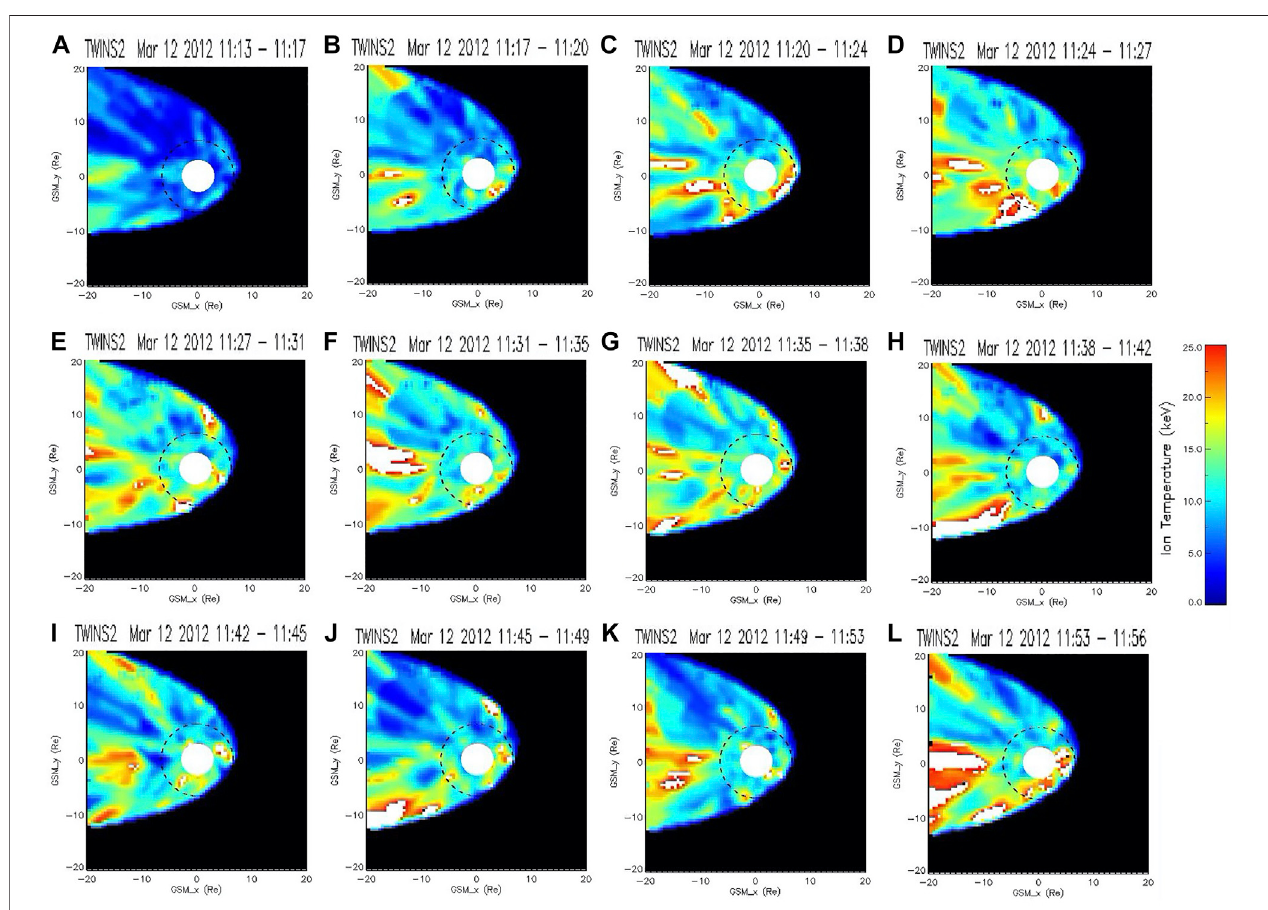
FIGURE4| Iontemperature mapsoftheGSMxy-planecalculatedfromTWINSmeasurementsfor11:13 – 11:56.TheSunistotheright,thewhitedischasaradius of 3 Re and is centered at Earth and the dashed line indicates geosynchronous orbit.